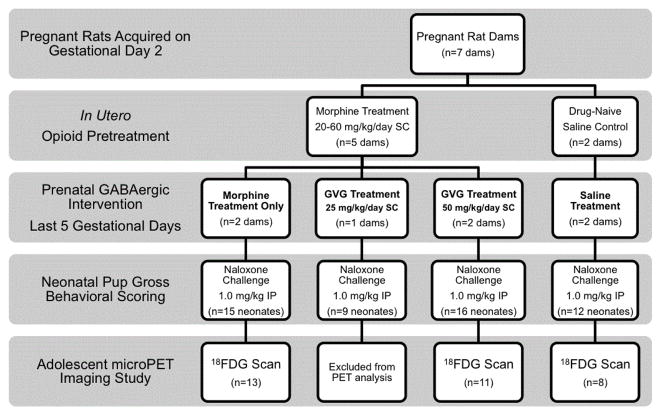
Study overview and timeline, Morphine was administered to pregnant dams in escalating dose (20–60 mg/kg/day) for the first 6 days and 60 mg/kg/day each day until parturition. Morphine +GVG groups received morphine in the same dose as morphine only groups. The morphine+GVG25 group received GVG at 25 mg/kg/day and the morphine+GVG50 group received GVG at 50 mg/kg/day. GVG was administered only for the last 5 days of gestation.